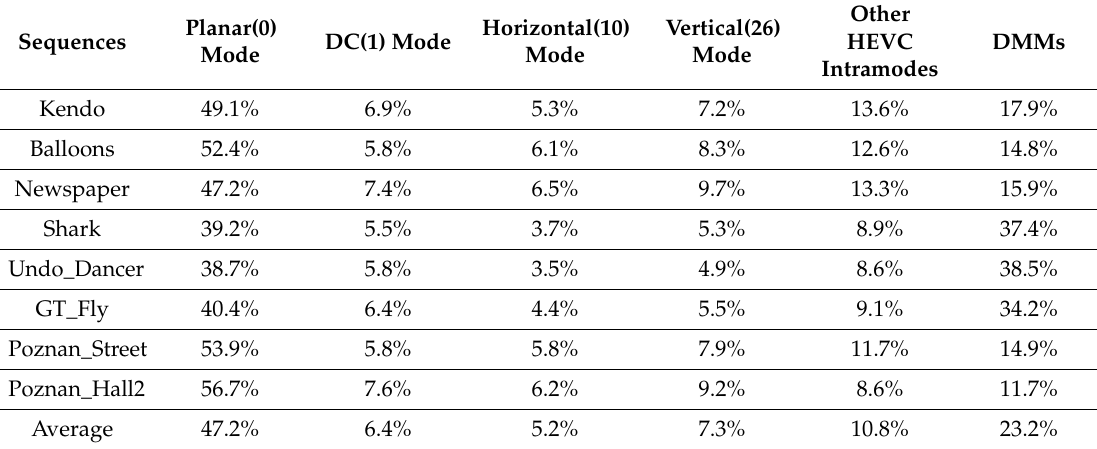
Table 6. Intramode distributions for complex region of treeblocks in depth map.